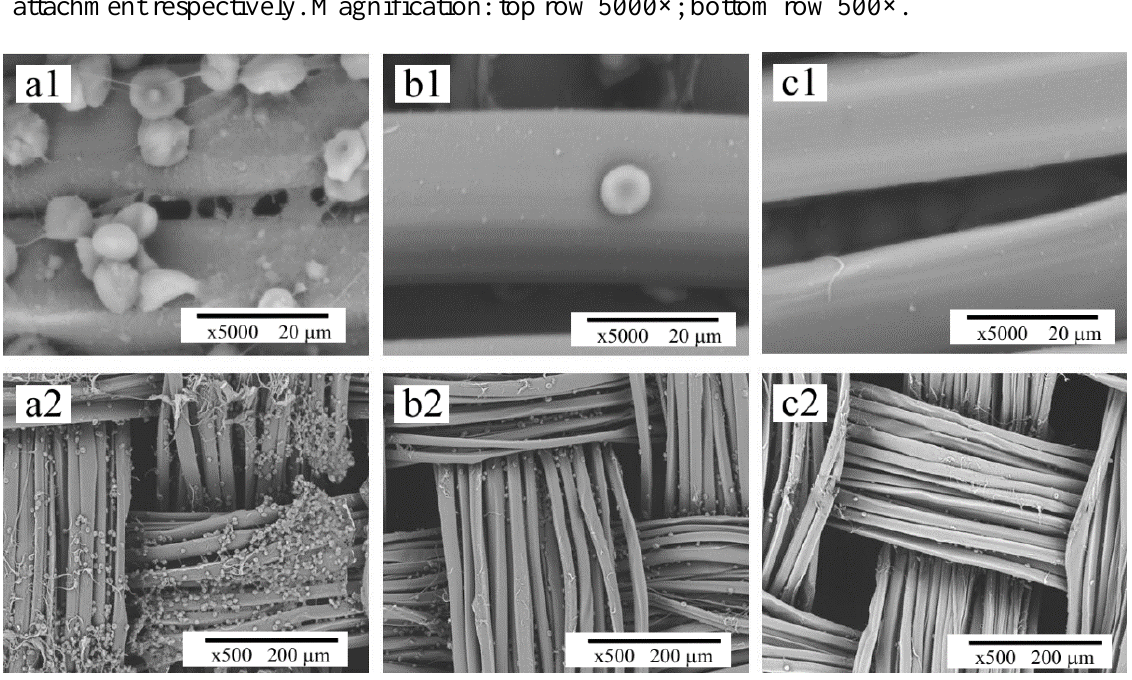
Figure 11. SEM photomicrographs of untreated and surface modified fibroin fabrics after exposure to whole blood: ( a1 , a2 ) Untreated SFF sample showing cell attachment; ( b1 , b2 ) SFF-1 and ( c1 , c2 ) SFF-2 surface treated samples show limited and no cell attachment respectively. Magnification: top row 5000×; bottom row